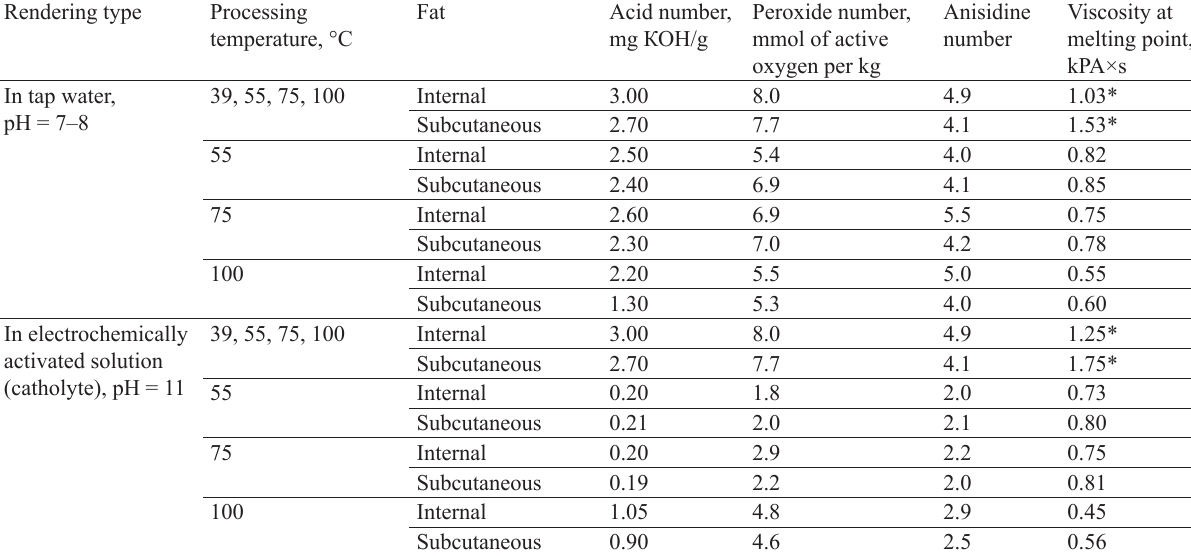
Table 3 Physicochemical indicators of ostrich fat obtained by electrochemical activation Rendering